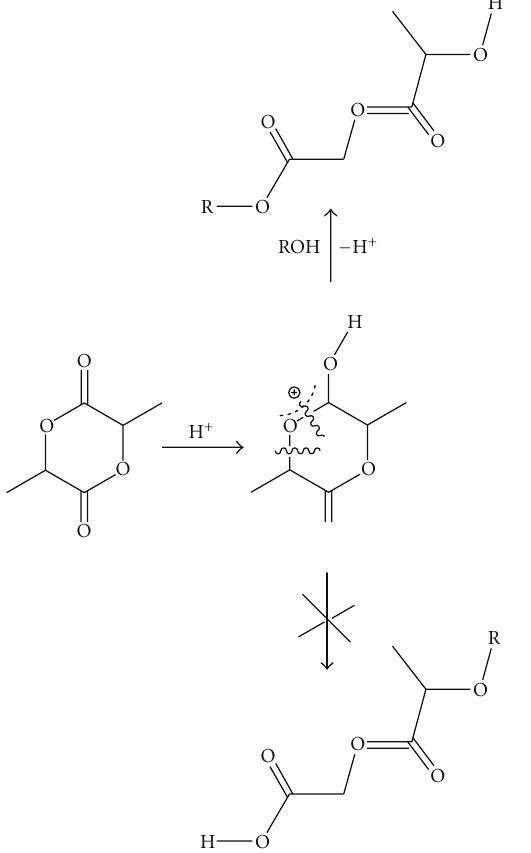
Scheme 6: Proposed Activated Monomer Pathway for Cationic ring-opening polymerization of lactone.